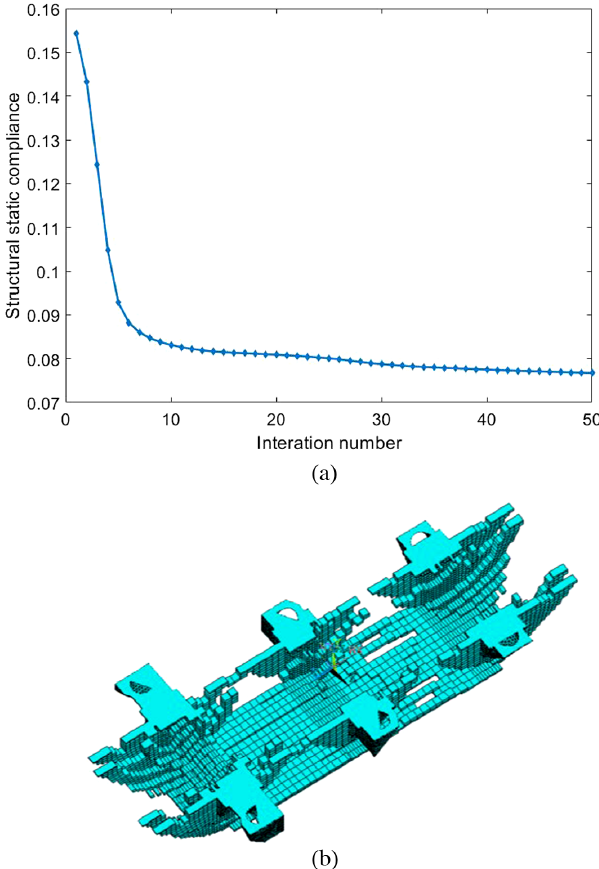
FIG. 3. Results of static optimization. (a) Convergence curve and (b) high pseudodensity elements.